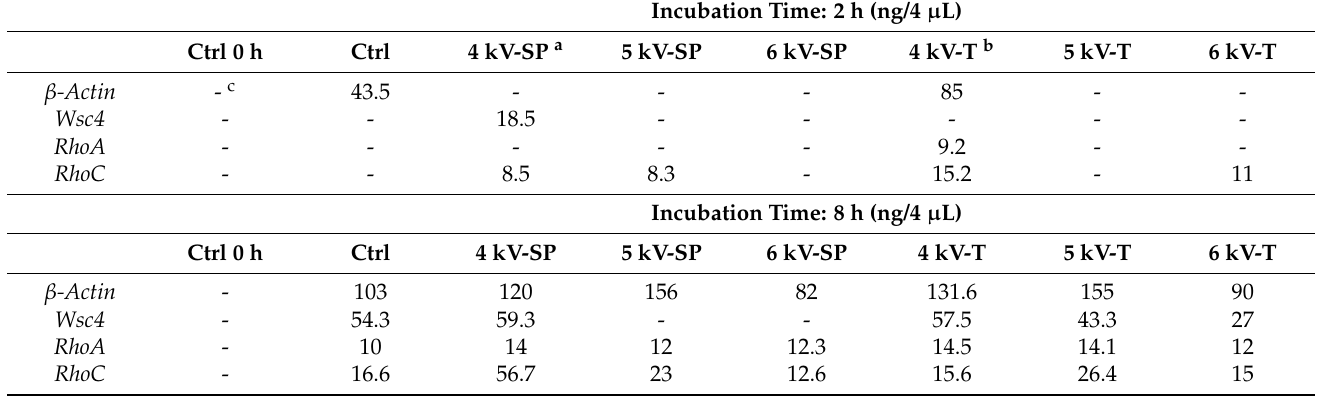
Table 3. Relative quantification values obtained by analyzing the band’s intensity in the electrophore- sis